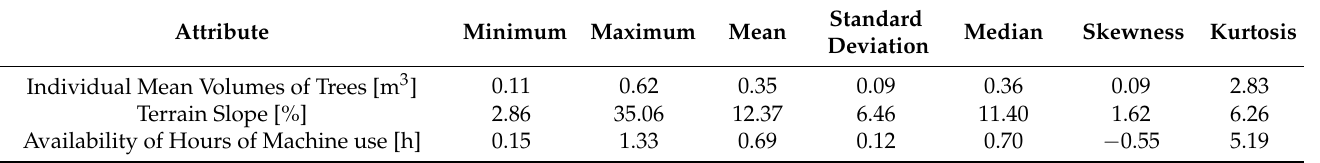
Table 3. Mean, standard deviation, and median of dataset from mechanized timber harvesting operation, after process of removing outliers of three initial attributes.